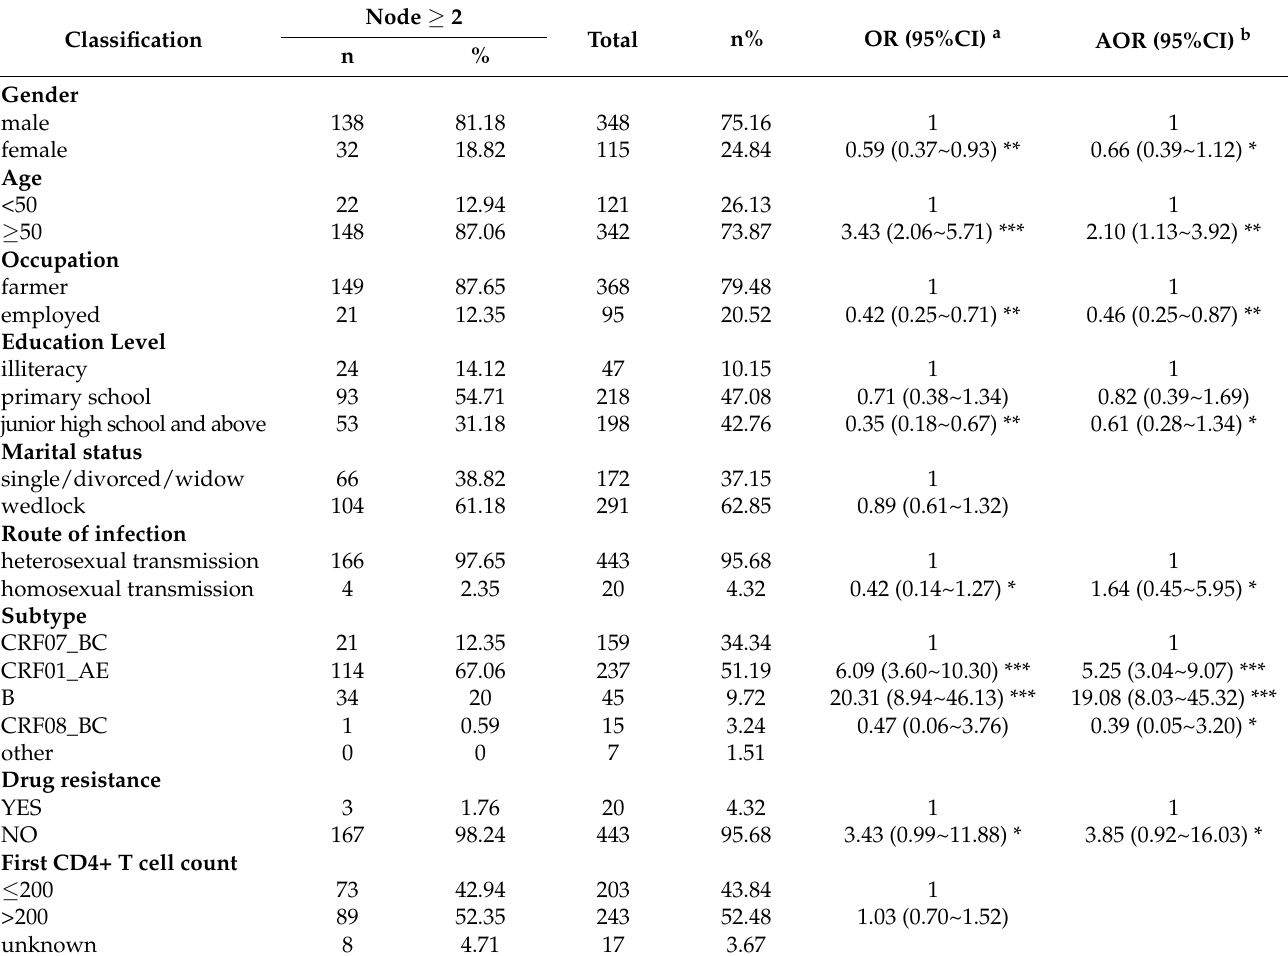
Table 1. Analysis of the influencing factors of the Pengzhou molecular network cluster nodes ≥